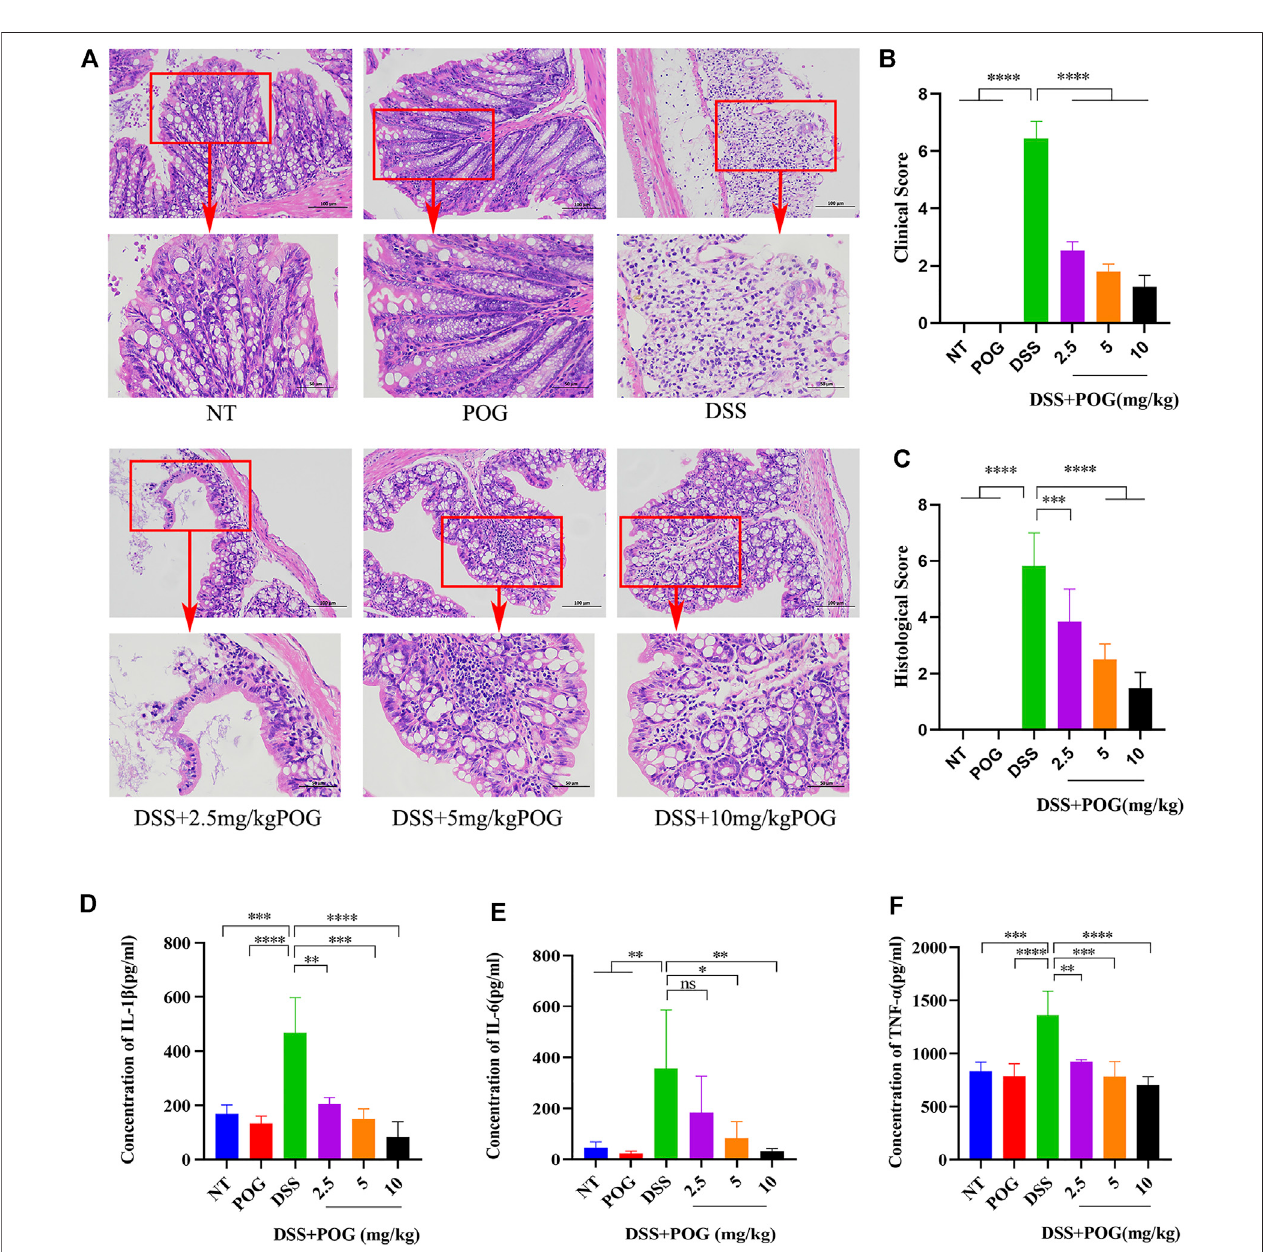
FIGURE2| POGprotectstheintestinaltissuefromdamageandinhibitstheproductionofrelatedin fl ammatoryfactors. (A) ColonictissueH&Estainingimagesofall groups. (B) DSS-induced clinicalscoresofulcerativecolitisinmice. (C) Colonhistological score. (D – F) Histogram ofin fl ammatory cytokine expression (IL-1 β ,TNF- α ,IL- 6). Data are means ± SD. *p < 0.05, **p < 0.01, ***p < 0.001, ****p <